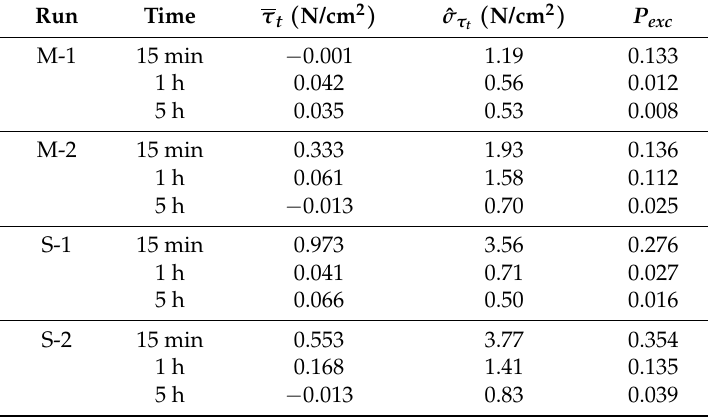
Table 3. Summary of the temporal variations in the Reynolds stress and the exceeding probability ( exc P ) at the lowest point of the scour hole.